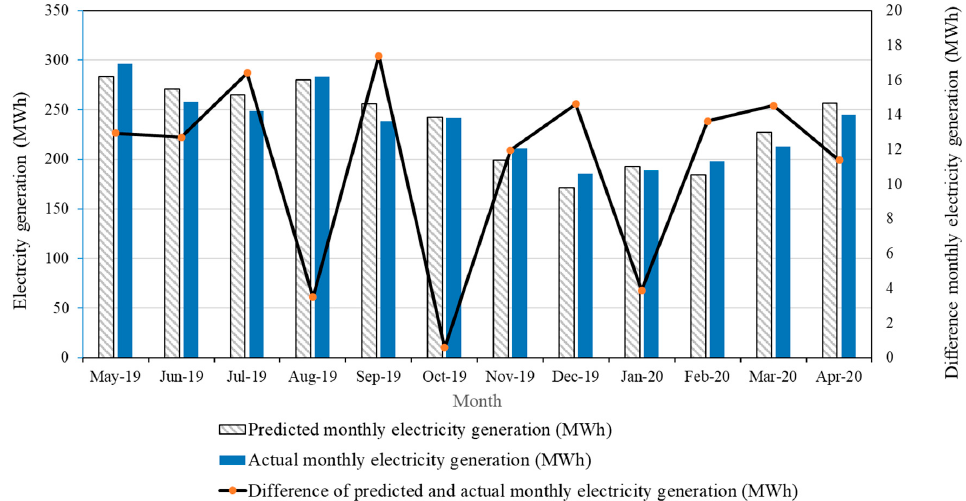
Figure 5. The predicted and the actual electricity generation in MWh.